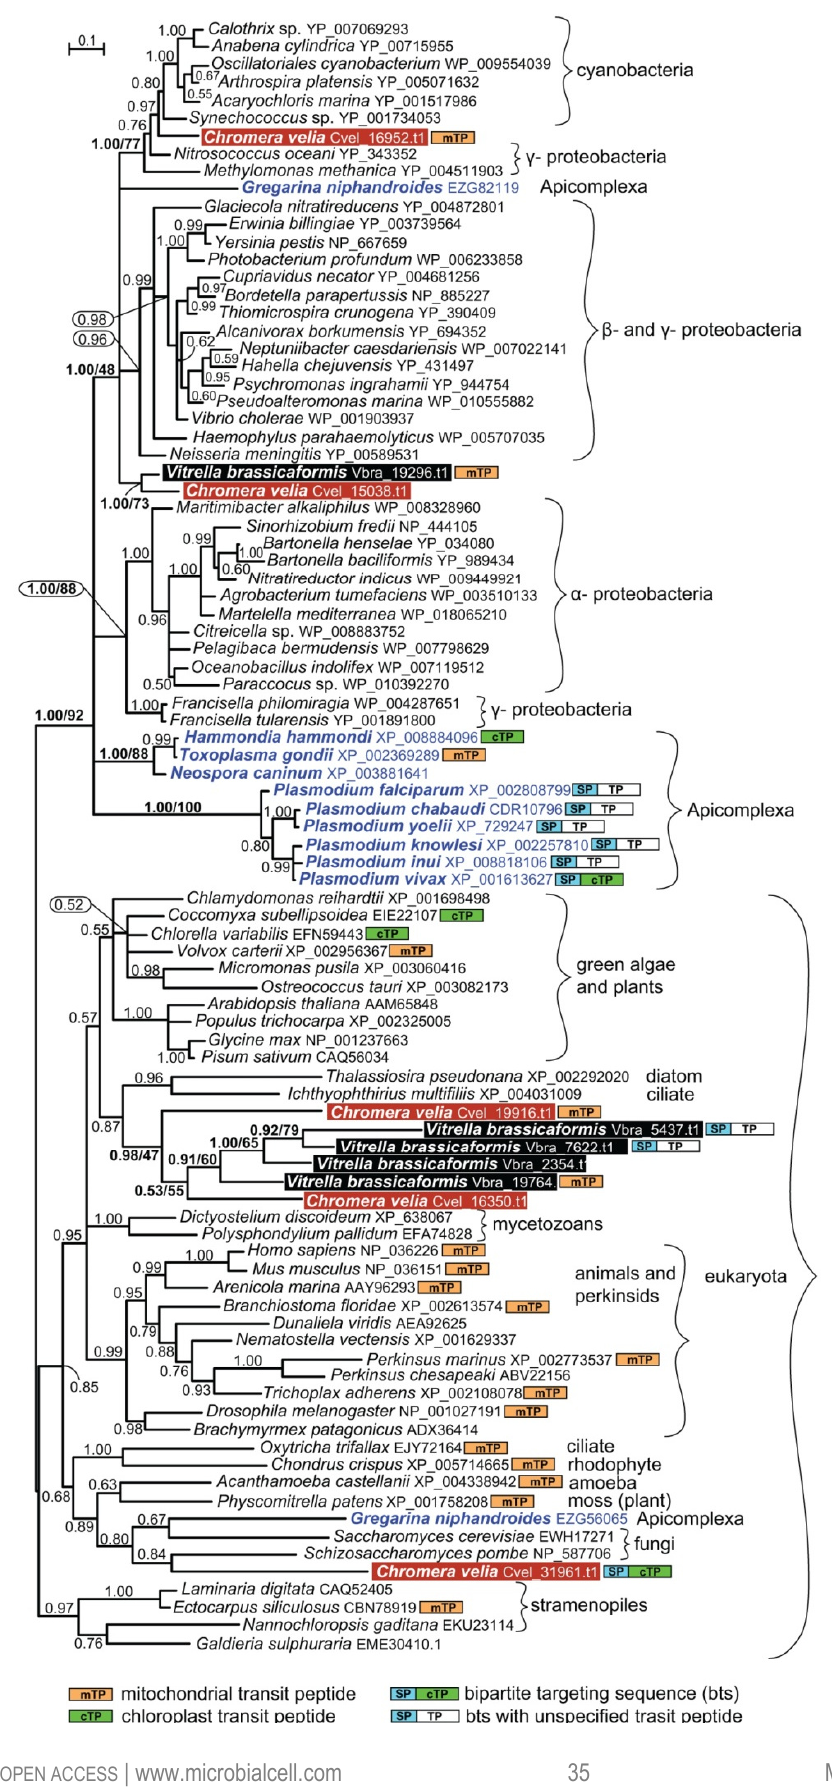
FIGURE 1: Bayesian phylogenetic tree as inferred from Prx5 amino acid